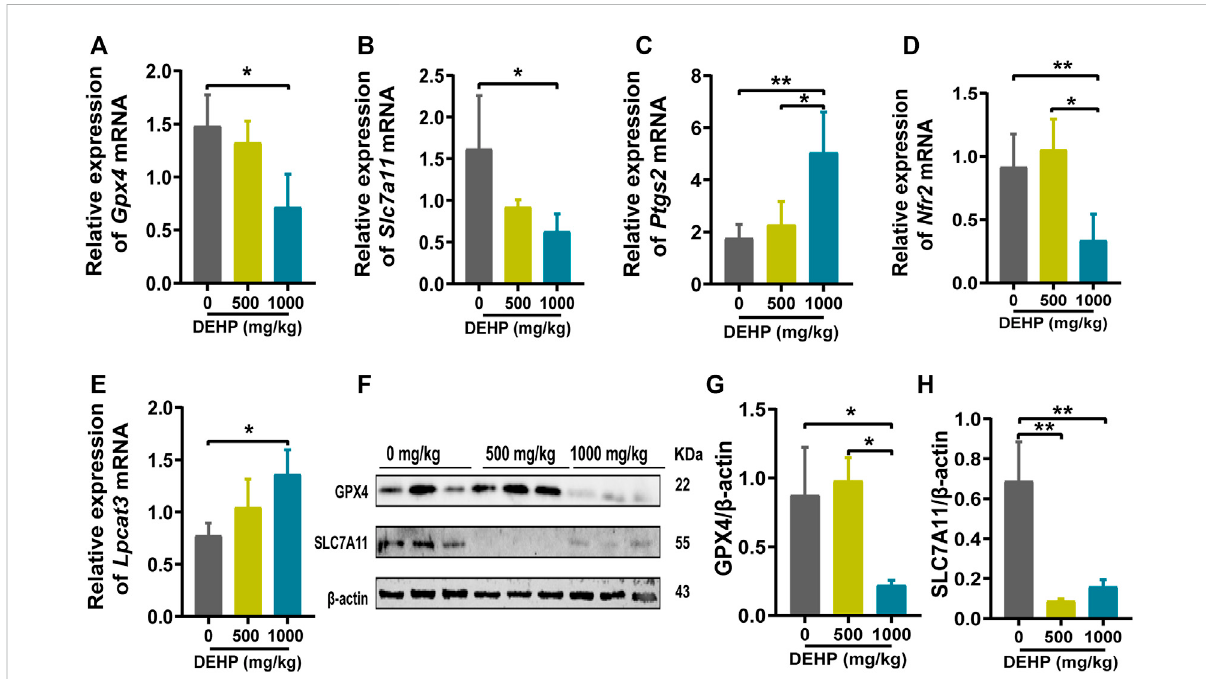
FIGURE 3 DEHPexposureledtoferroptosisinmicelivers. (A – E) mRNAlevelswereevaluatedbyRT ‒ qPCRoftheselectedferroptosisgenes Gpx4,Slc7a11, Ptgs2, Nrf2,andLpcat3 , and β -actin wasused as thereference gene. (F) Protein levels ofGPX4 and SLC7A11 in thelivers ofmice; β -actin was used as the reference protein. (G,H) Quanti fi cation of the protein levels of GPX4 and SLC7A11 in the livers of mice. Experiments were repeated at least three times. Data are presented as the mean ± SD. * p < 0.05, ** p < 0.01, *** p <